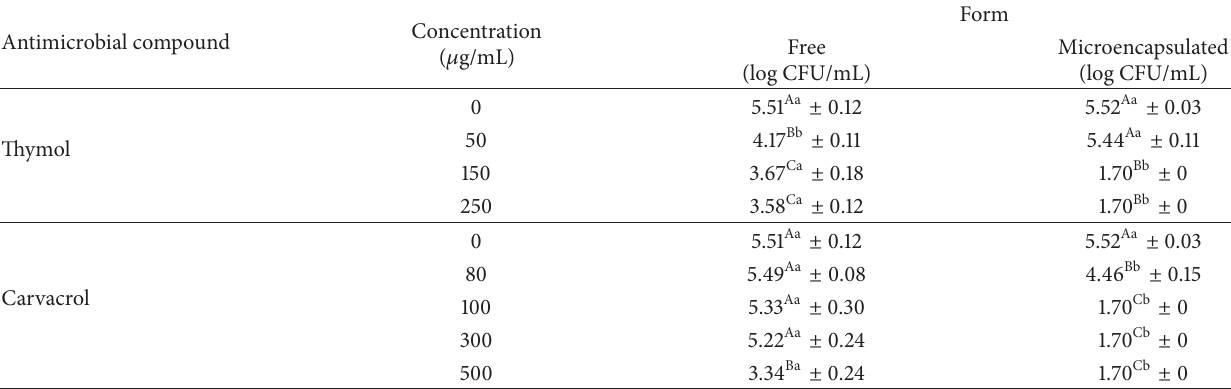
Table 3: Free and microencapsulated thymol and carvacrol antimicrobial activity against Micrococcus luteus determined by the broth dilution method. After 2 hrs incubation at 30 ∘